Question: Give a one-sentence summary of this figure.
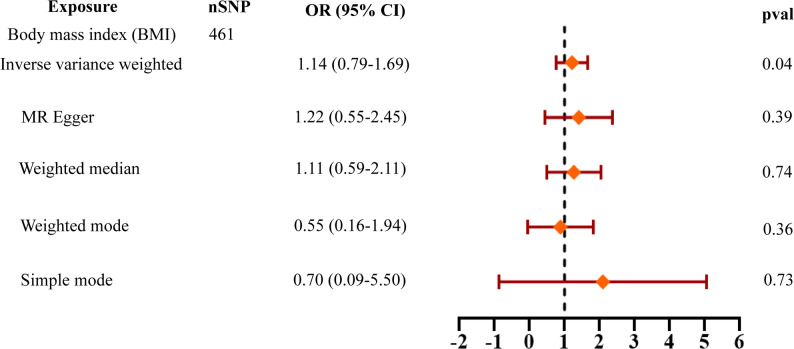
Answer: Forest plot of Mendelian randomization (MR) analysis of the BMI-MM risk relationship